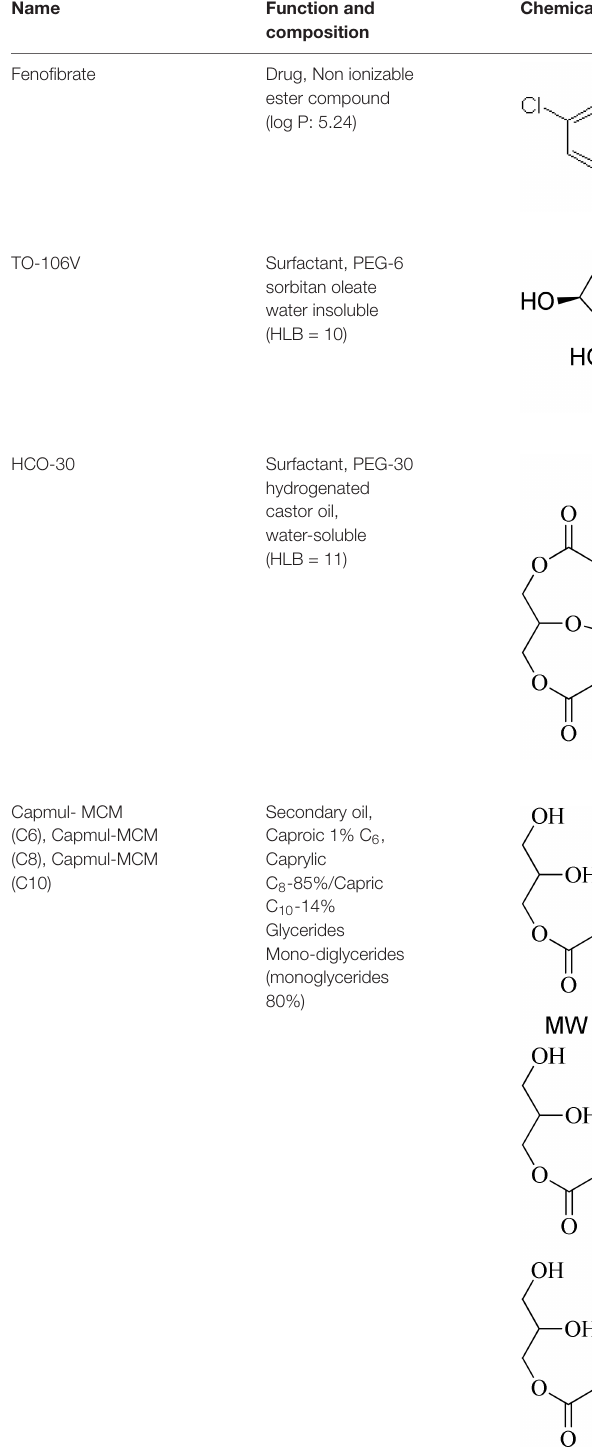
TABLE 1 | Description of the lipids and their chemical structures.